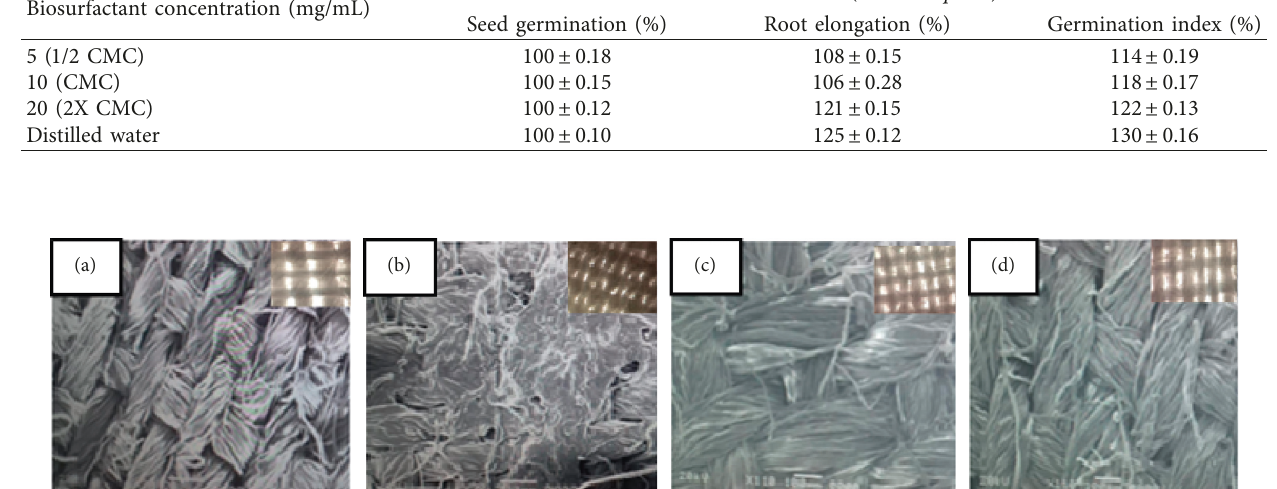
Anion seeds ( Allium cepa L. )